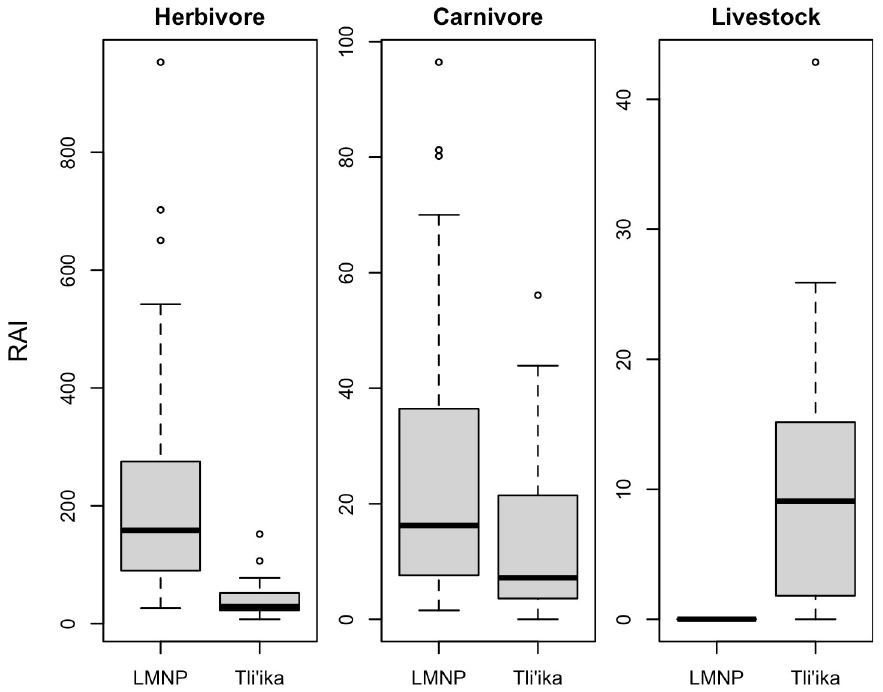
Fig 3. Boxplots, comparing relative abundance indices (RAI; camera trap events/100 trap nights) across functional groups of mammals in Tli’ika and Lake Manyara National Park (LMNP), in northern Tanzania.